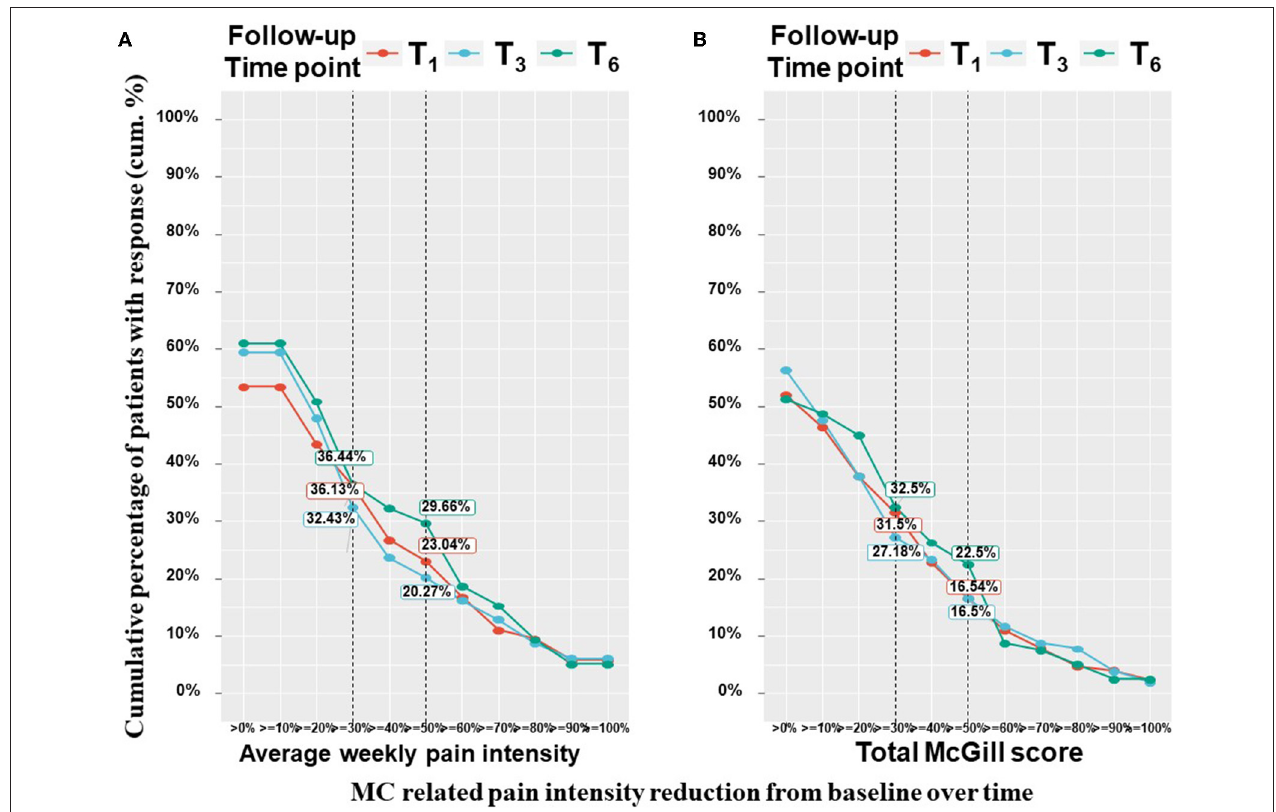
FIGURE 3 | Pain measures cumulative treatment response rates per time point. T 1 , 1-month Follow-Up; T 3 , 3-month Follow-Up; T 6 , 6-month Follow-Up; MC, medical cannabis; The percentages on the Y-axis indicates the cumulative percentage of patients with a response; Every point on the X-axis represent the percentage of MC related pain intensity reduction from baseline, no change values or an increase of pain intensities are not represented in this figure; These figure displays percentages from the entire cohort ( n = 212 at T 1 , n = 158 at T 3 , n = 126 at T 6 ) but only positive (pain decrease) reports are